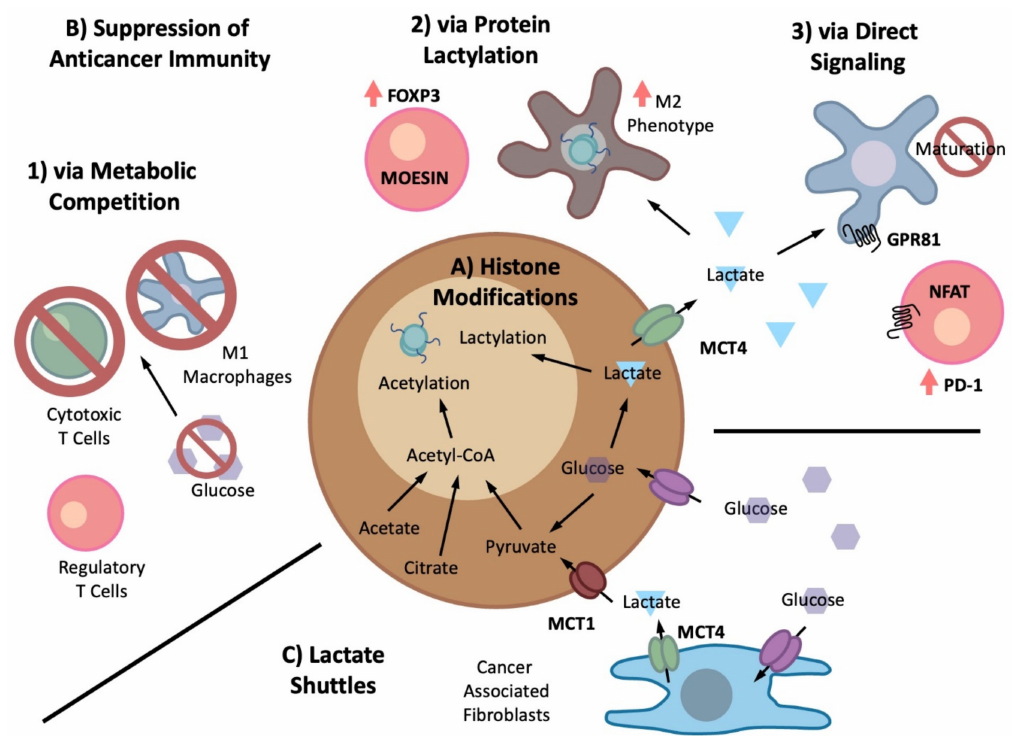
Figure 4. Altered glucose metabolism in aggressive PCa and the effects of increased lactic acid production on ( A ) gene regulation via histone modifications, and ( B , C ) the TME, especially its impacts on suppressing the anticancer immune